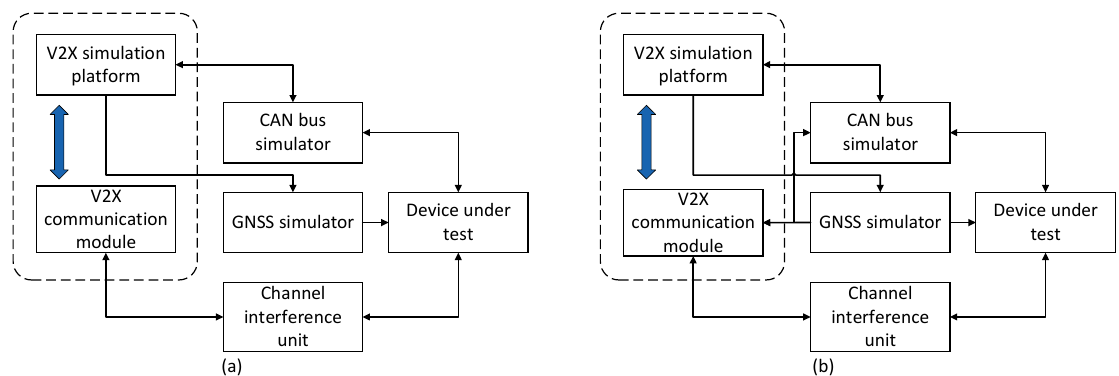
Figure 5. Function Test System Architecture. ( a ) the V2X simulation platform directly generates application messages and sends them to the V2X communication module; ( b ) the V2X communication module generates corresponding application messages according to the simulation data from the GNSS simulator and the CAN bus